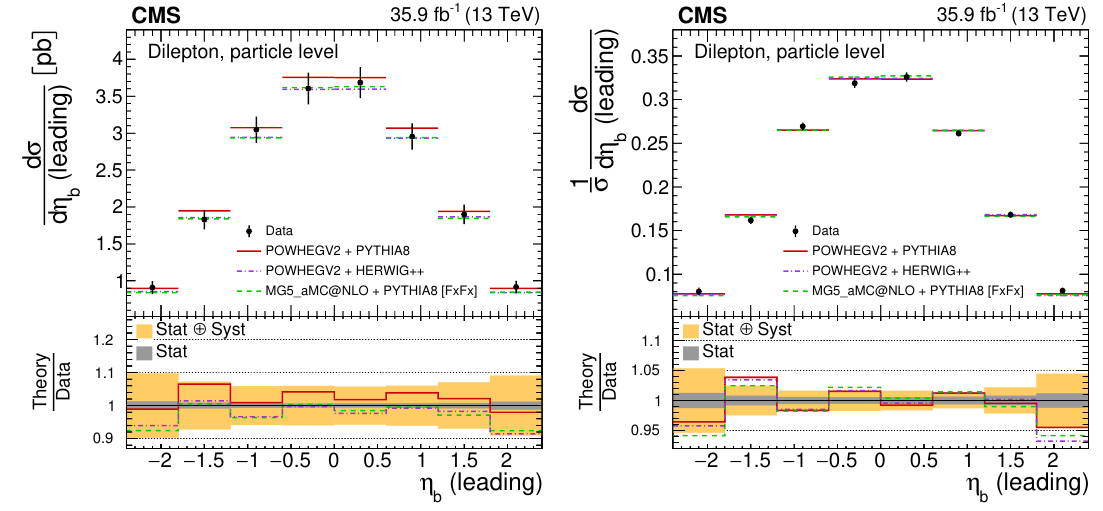
Figure 47 . The di(cid:11)erential tt production cross sections as a function of (cid:17) b (leading) in a (cid:12)ducial phase space at the particle level are shown for the data (points) and the MC predictions (lines). The vertical lines on the points indicate the total uncertainty in the data. The left and right plots correspond to absolute and normalised measurements, respectively. The lower panel in each plot shows the ratios of the theoretical predictions to the data. The dark and light bands show the relative statistical and total uncertainties in the data, respectively.